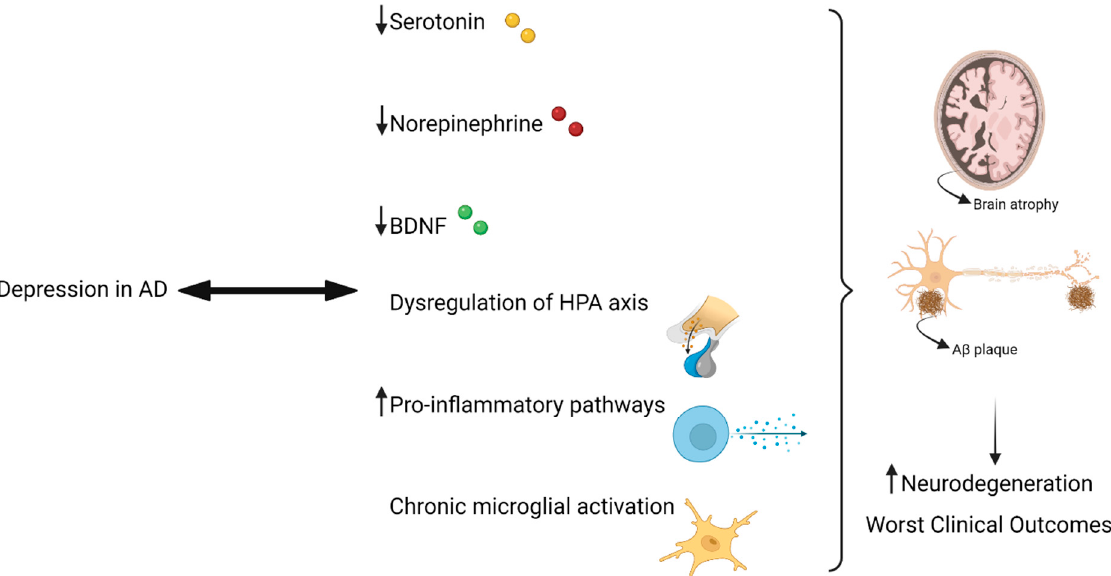
Figure 2. Findings such as decreased levels of 5-HT, NE, and BDNF, as well as dysregulation of the HPA axis and pro- inflammatory pathways, are associated with depression, contributing to the increase in neurodegeneration phenomena present in AD, such as the presence of A β plaques and brain atrophy. Reprinted with permission from ref. [48]. Copyright 2019 Frontiers Media S.A. Created with BioRender.com [49]. Available online: https://biorender.com/ (accessed on 16 Au- gust 2021).